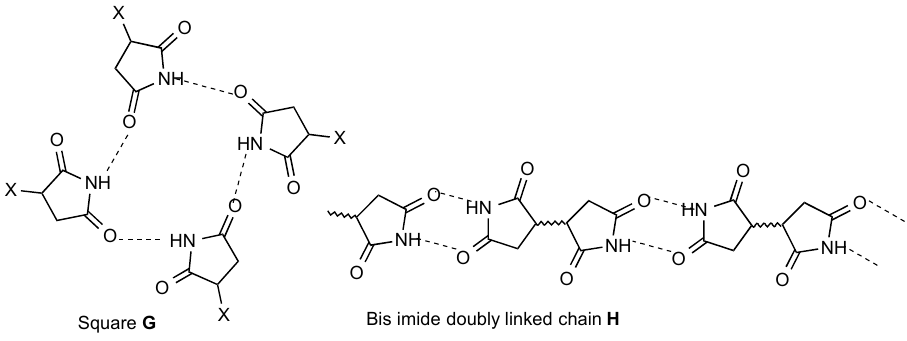
Figure 2. Less common hydrogen bonding patterns.